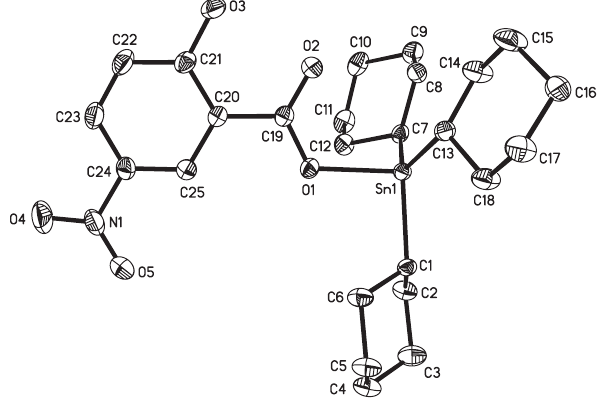
Figure 2: The molecular structure of 2 . Hydrogen atoms are omitted for clarity.